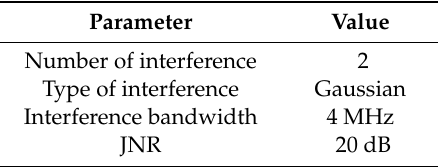
Table 3. Interference